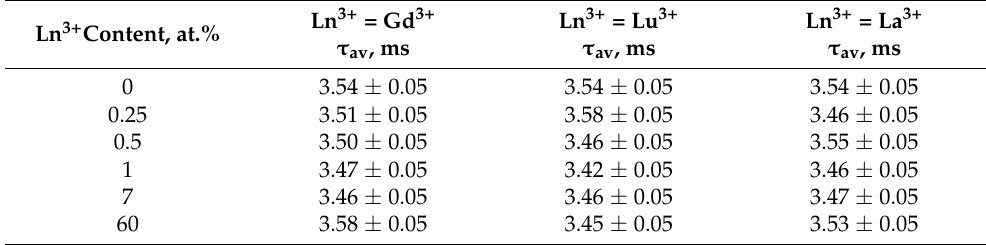
Table 1. Lifetimes of 4 G 5/2 excitation state of Sm 3+ ion in NaY 0.98-x Sm 0.02 Ln x F 4 (Ln = Gd, Lu, La). Ln 3+ Content,